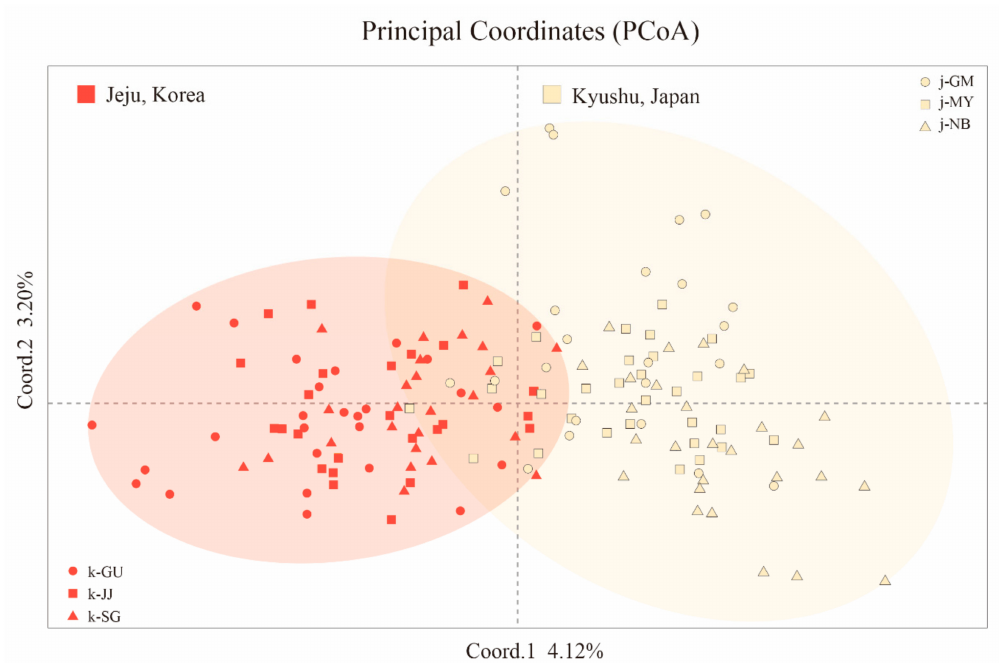
Figure 4. Neighbor-joining (N-J) tree based on F st genetic distance among populations. Figures in tree branches are percentage bootstrap values estimated from 1000 reiterations. The square marks indicate the overall genotype assignment for each population to particular genetic clusters based on STRUCTURE analysis.